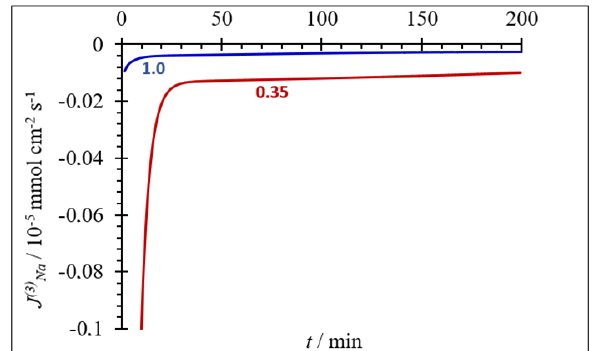
Figure 21. Simulated time dependencies of ion fluxes towards the desalination compartment (negative direction of axis for the case of AEM). The fluxes of Na + ions through the pristine AMX (blue line) and used for 400 h in ND AMX (red line) membranes are simulated at the values of the fraction of strongly basic fixed groups equal to 1 and 0.35, respectively (indicated near the curves).